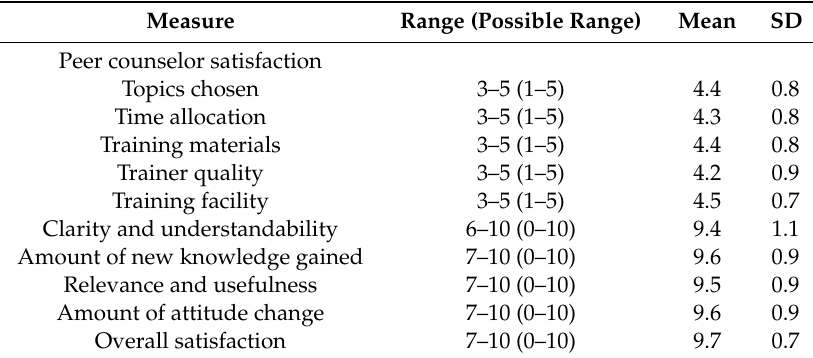
Table 4. Training evaluation of peer counselors.